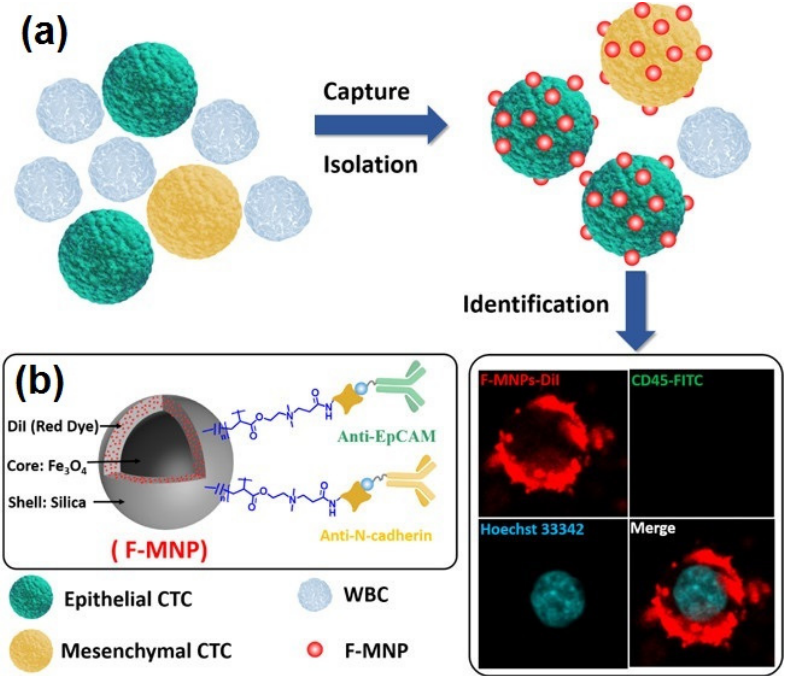
Figure 29. ( a ) Capture and identification of circulating tumor cells (CTCs) using fluorescent magnetic nanoparticles (F-MNPs) and ( b ) the structure of the antibody-functionalized modified F-MNPs. Adapted with permission from reference [133]. Copyright 2019 American Chemical Society.